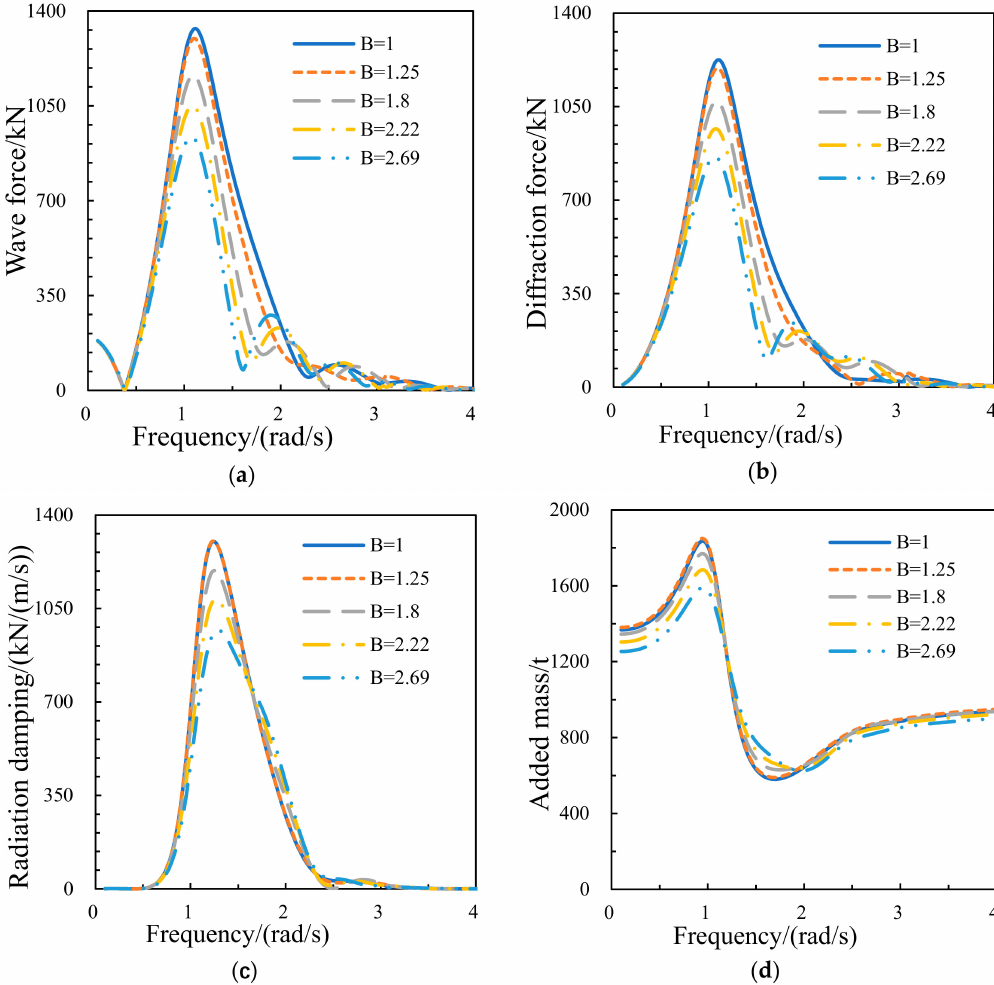
Figure 4. Four hydrodynamic parameter curves: ( a ) wave force, ( b ) di ff raction force, ( c ) radiation damping, ( d ) added mass.